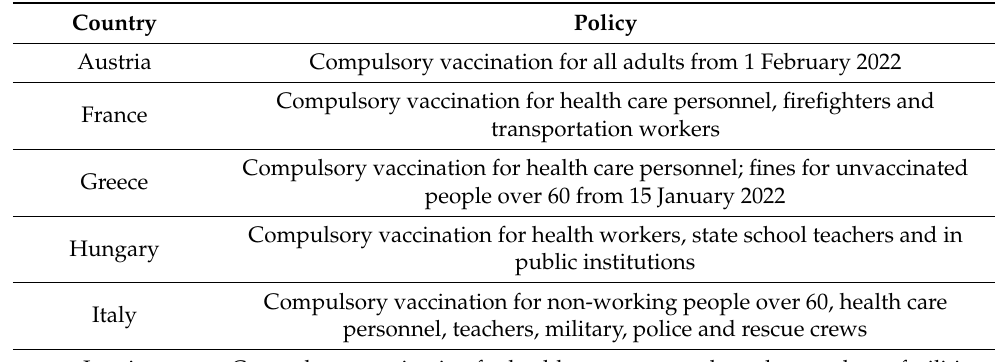
Table 1. EU countries’ compulsory vaccination policies by 6 January 2022. Country